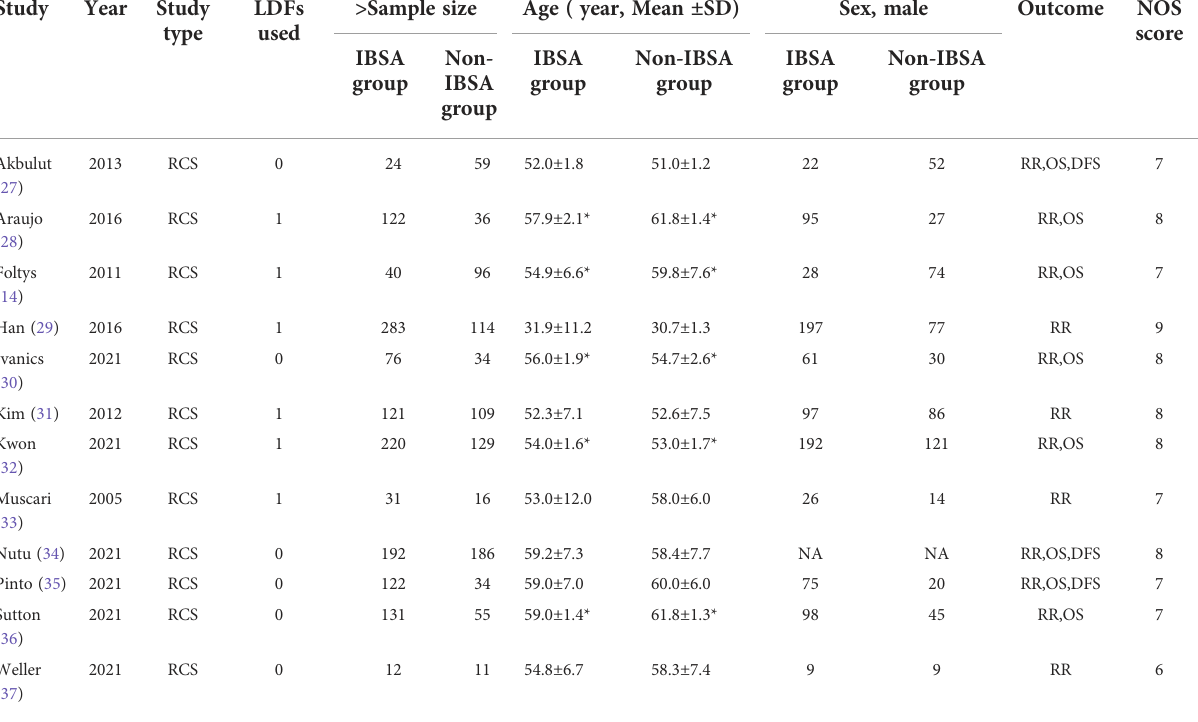
TABLE 1 Characteristics of included